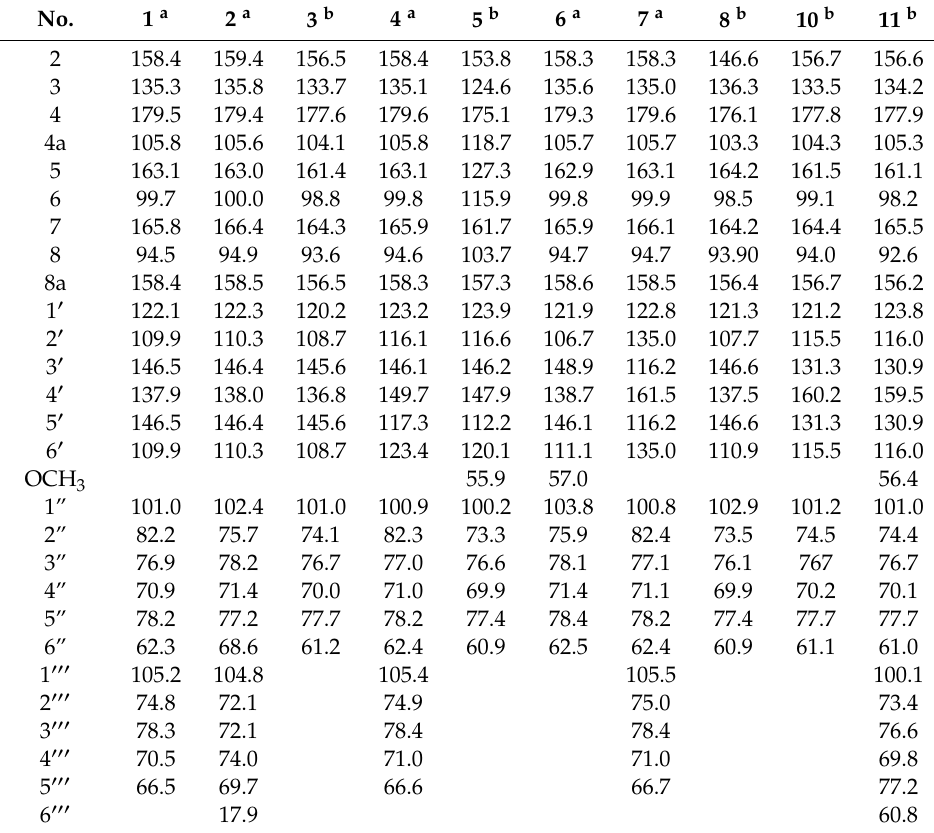
Table 1. 13 C NMR spectroscope data of compounds 1 – 8 and 10 – 11